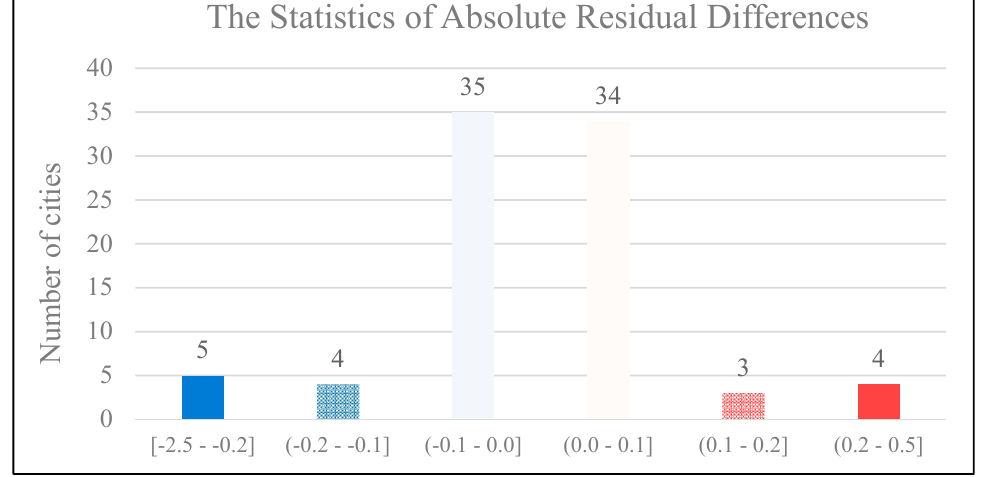
Figure 15. Statistical result of the difference between two residuals.